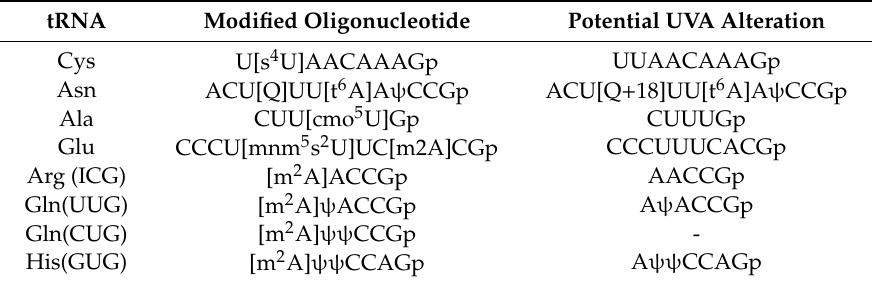
Table 2. UVA-induced e ff ects on representative tRNA following cellular exposure.